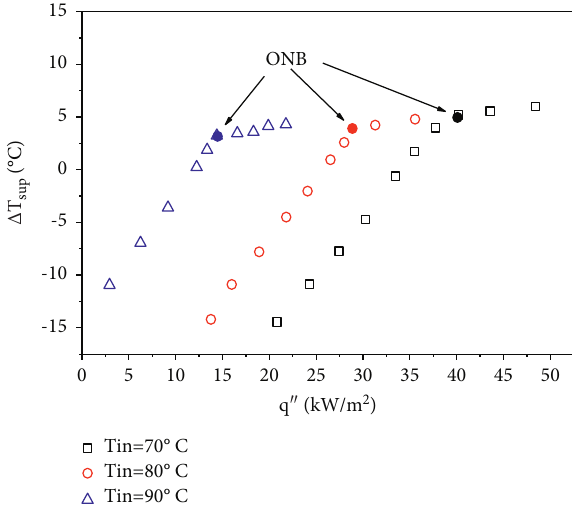
Figure 8: Wall superheat at a fixed point in channel b ( T 100kg/(m 2 · s)).